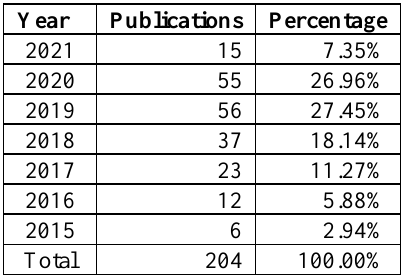
Table 5. Distribution of publications by year